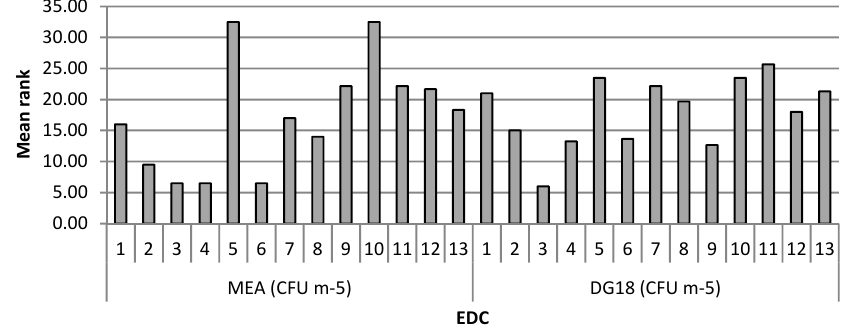
Figure 4. Mean ranks of fungal load (CFU m − 2 ) on MEA and DG18 on EDC in each bakery.